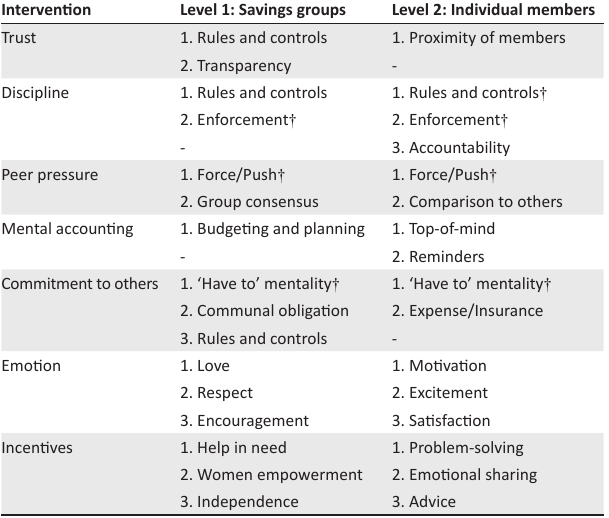
TABLE 3: Comparison of levels 1 and 2 responses: Research question 2.